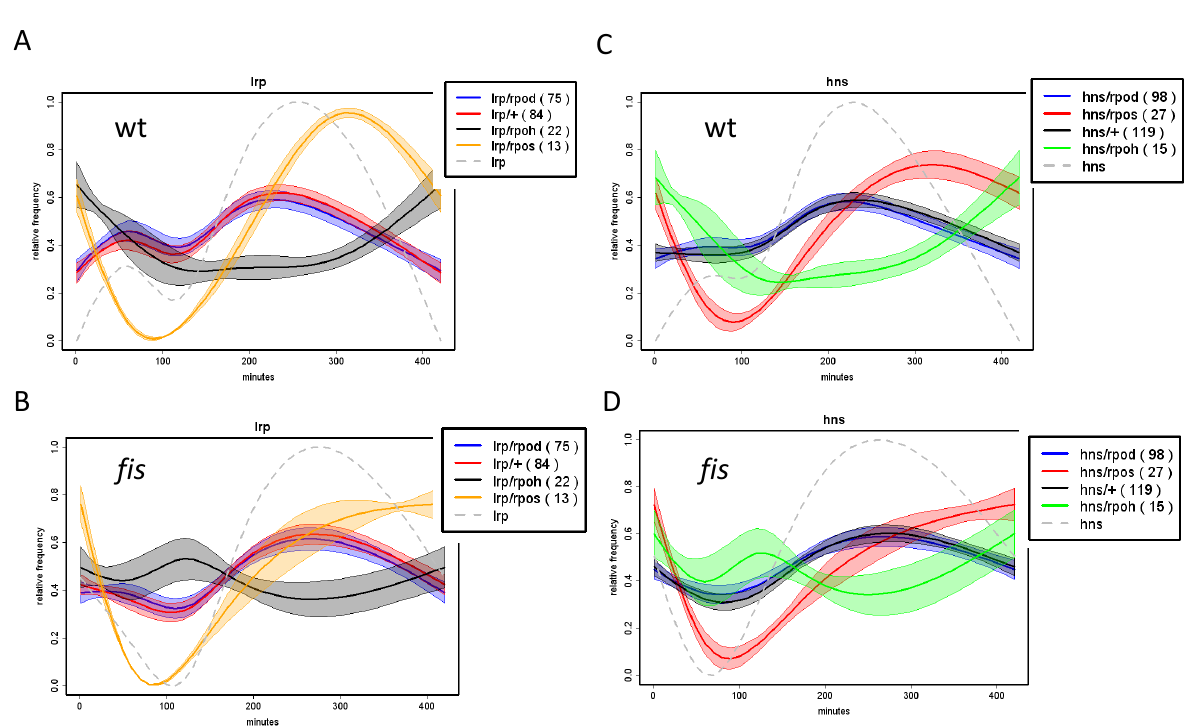
Figure 11. Modulation of the expression of NAP genes affects the temporal patterns of corresponding regulons and couplons. ( A ). Expression patterns of lrp gene Lrp regulon and Lrp couplons in wild type (wt) cells (color-code indicated in the inset). Numbers in round brackets indicate the number of genes involved in the respective regulon or couplon. The different curves were normalized to [0;1] to compare them in one plot. The envelopes of the curves indicate the standard deviation at 10% random remapping of the expression patterns to genes. ( B ). The same as in ( A ) but in the fis mutant cells. ( C ). Expression patterns of hns gene, H-NS regulon and H-NS couplons in wild type cells. ( D ). The same as in ( C ) but in the fis mutant cells. Note that mutation of fis gene alters the expression pattern of lrp and hns genes (grey dashed lines) as well as the patterns of Lrp and H-NS couplons (data from [29]). The experimental procedure was as described in the legend to Figure